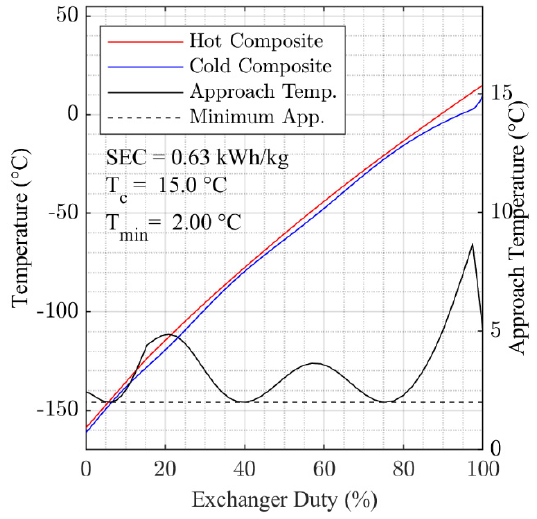
Figure A3. Optimized composite cooling curves for 15 ◦ C cooling temperature.